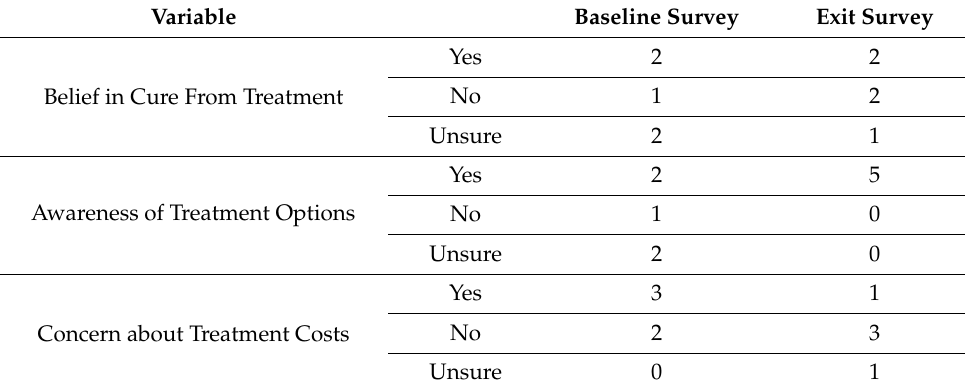
Table 3. Change in perceptions about treatment ( N =